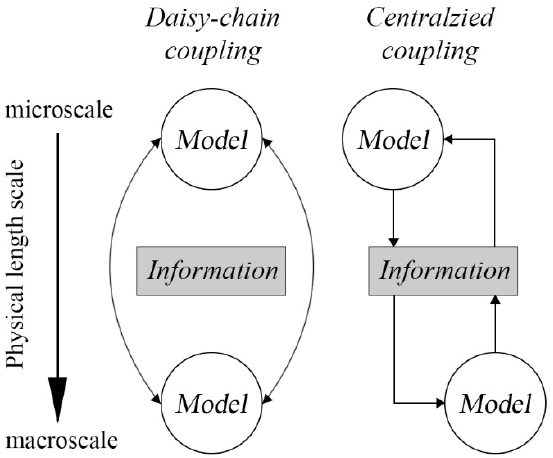
Figure 1. Schematic diagrams of common multiscale coupling schemes.